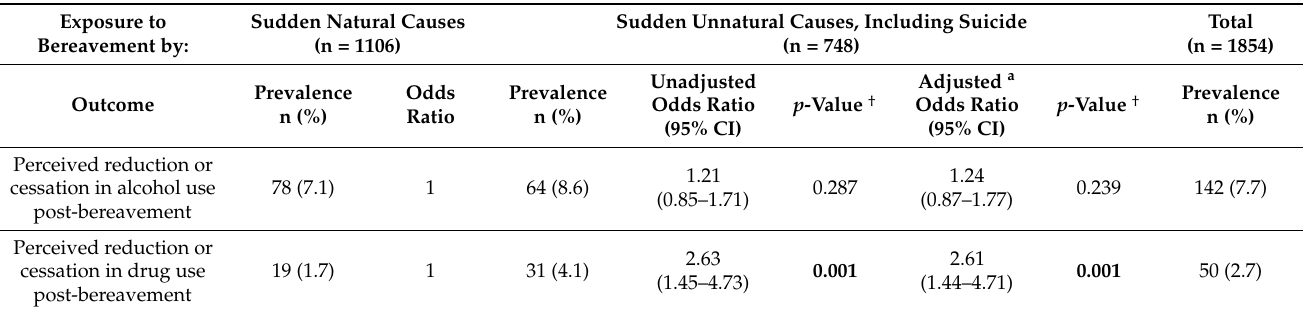
Table 2. Associations between bereavement by unnatural causes and perceived reduction/cessation in substance use.